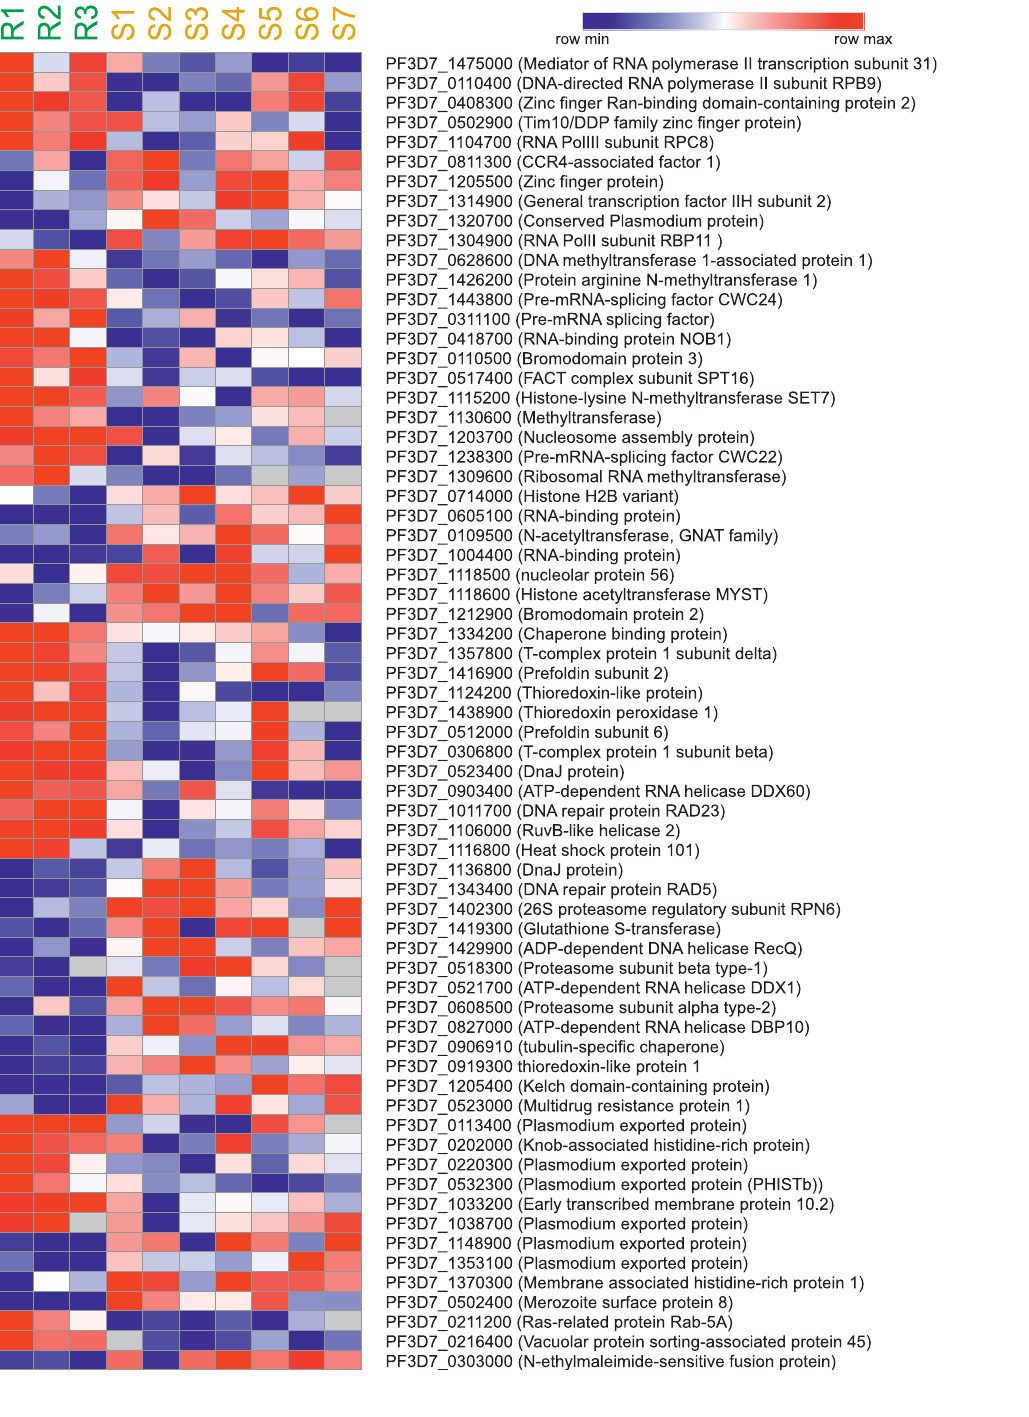
Frontiers in Genetics |